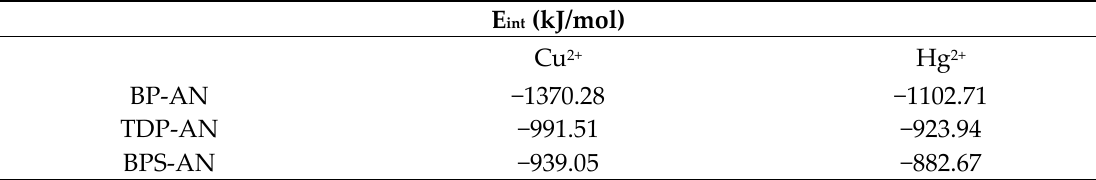
Table 2. Adsorption energies of metal cations on anthracene derivatives (Eint) in